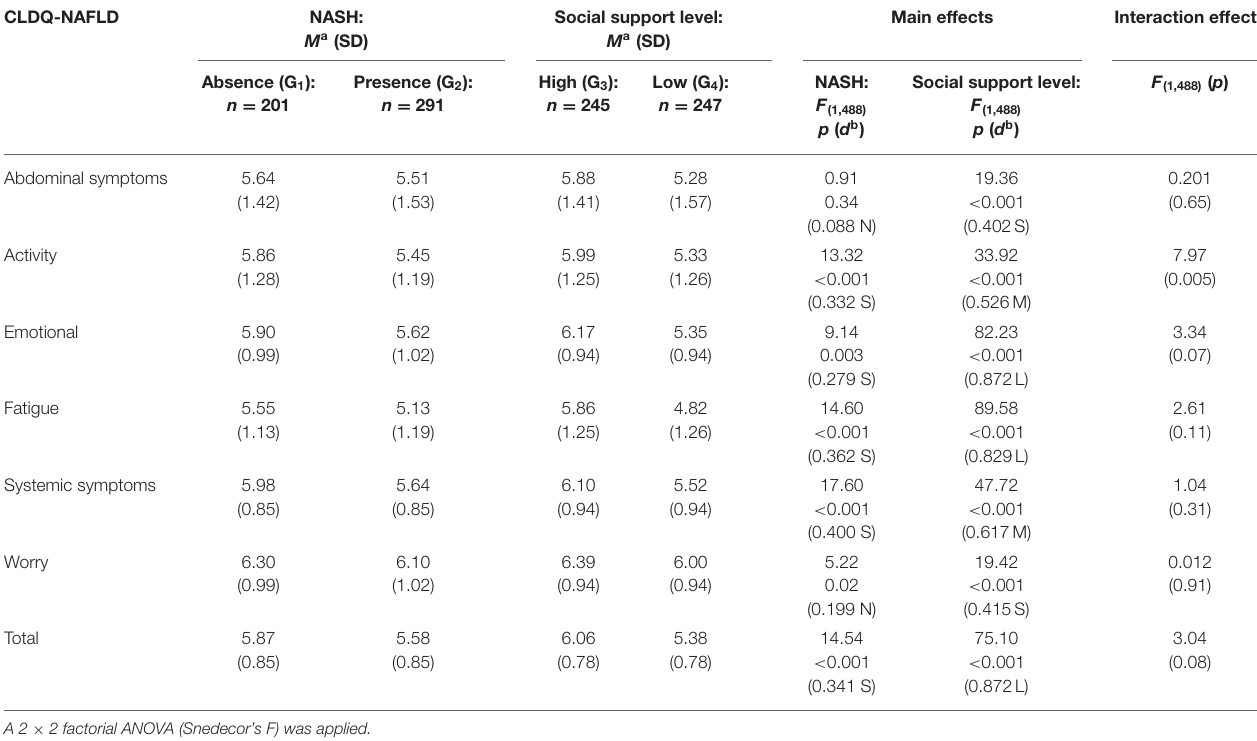
TABLE 2 | Quality of life (CLDQ-NAFLD) of non-alcoholic fatty liver disease (NAFLD) patients based on non-alcoholic steatohepatitis (NASH; absence and presence) and social support level (high and low) variables. CLDQ-NAFLD NASH: Social support level: M a (SD) M a (SD)